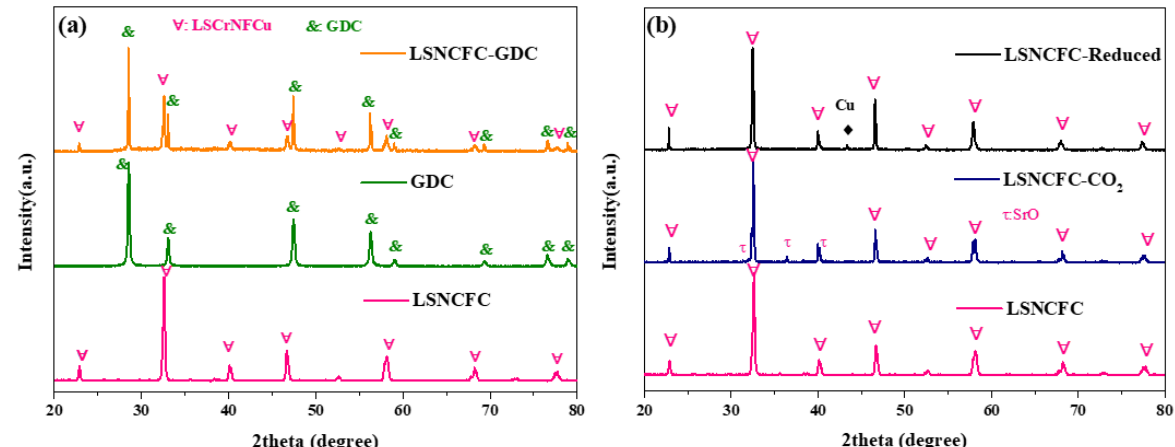
Figure 3. XRD patterns of ( a ) N-LSCFC, GDC, and N-LSCFC-GDC; ( b ) atmospheric treatment of H 2 and CO 2 for N-LSCFC.